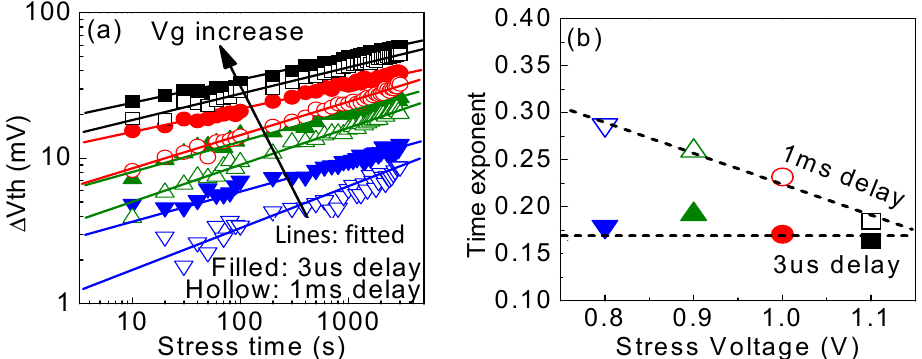
Figure 47. ( a ) Fitting power law with the measured total Δ Vth. The lines are fitted, and the symbols are measured data. ( b ) The extracted power exponent depended on the delay time and stress bias [39].